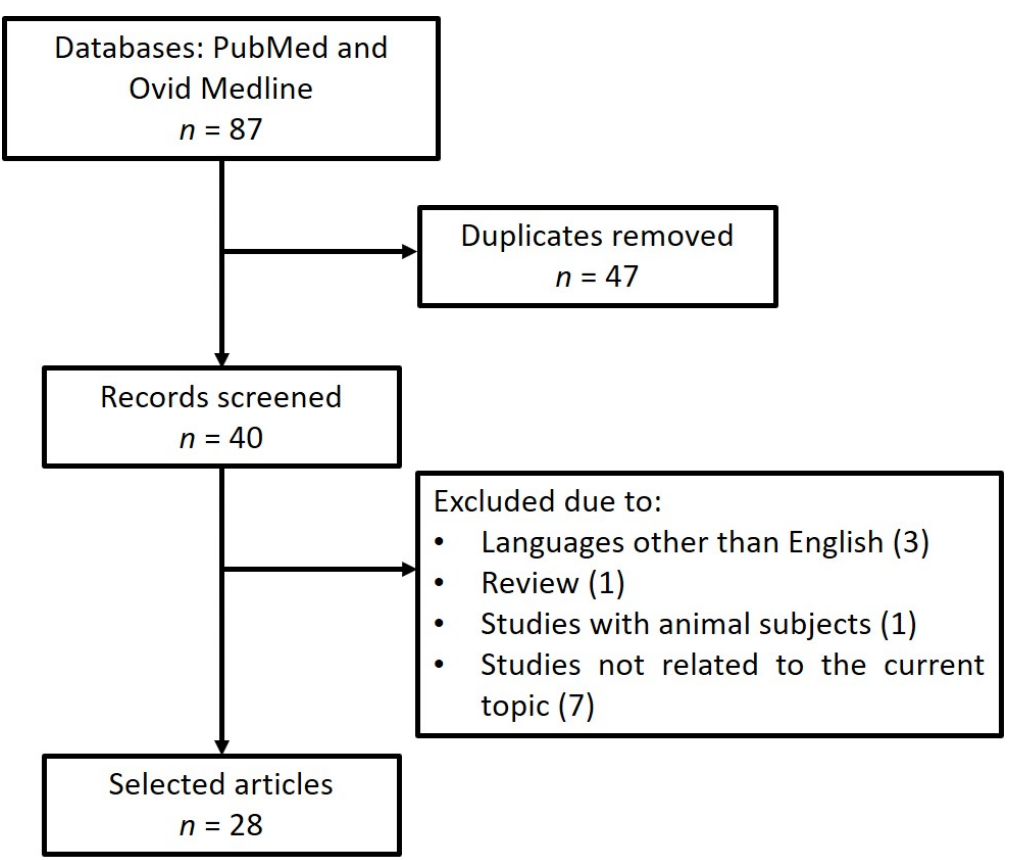
Figure 1. PRISMA flow diagram of study selection for 22q11.2 deletion syndrome and scoliosis. Table 1. Analysis of the current literature for individuals with 22q11.2 deletion syndrome and sco- liosis.